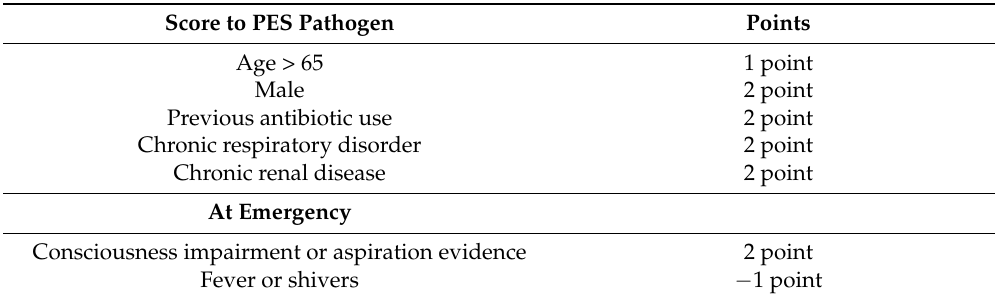
Table 3. PES score. Adapted from Reference